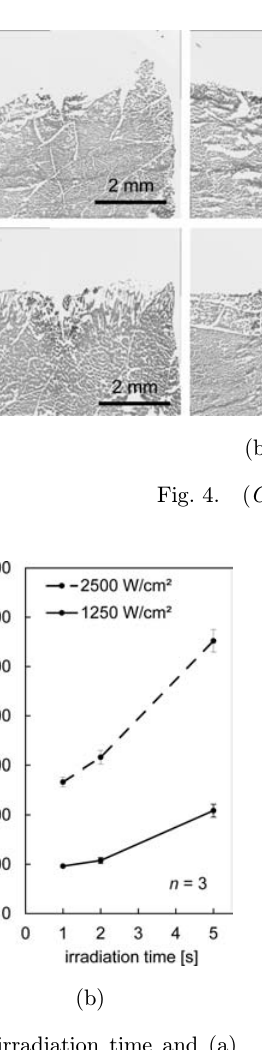
Fig. 5. Relationship between QCL irradiation time and (a) coagulation width (b) ablation depth.